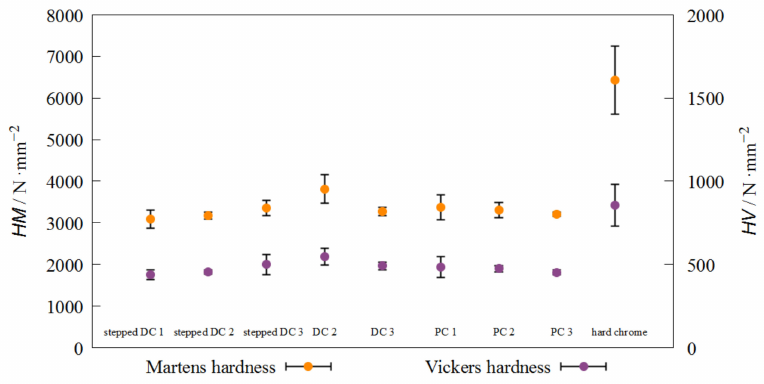
Figure 8. Martens and Vickers hardness of cross-section of electrodeposited Fe-Cr-Ni layers.